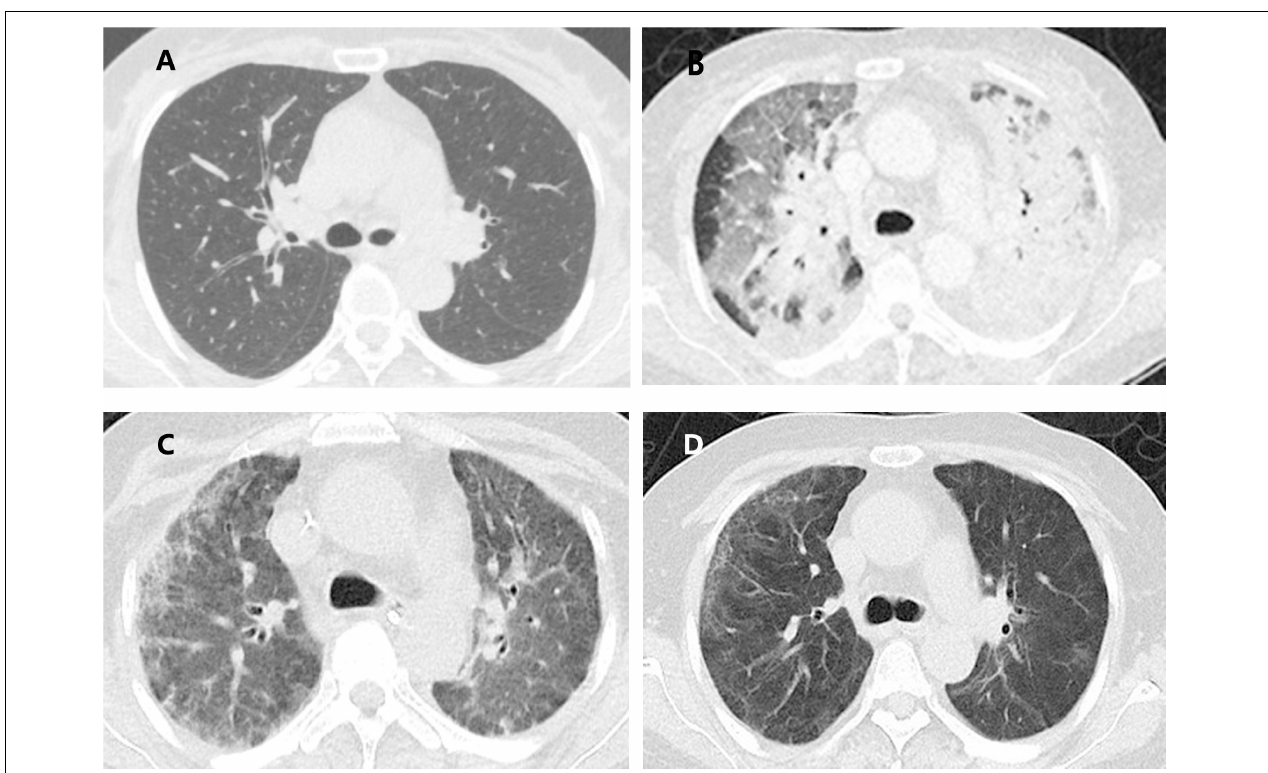
FIGURE 1 | Evolution of the computed tomography (CT) findings of the patient. (A) Scattered solid nodules in both lungs, with fibrous stripe shadow in the medial middle lobe of the right lung and slight enlargement in the left hilum; (B) patchy areas of ground glass opacities (GGO), consolidation in the double lungs scattered all over both lungs and slightly enlarged mediastinal lymph nodes; (C) consolidation and GGO in both lungs decreased compared with the previous one; (D) only a small amount of GGO and fibrous stripe